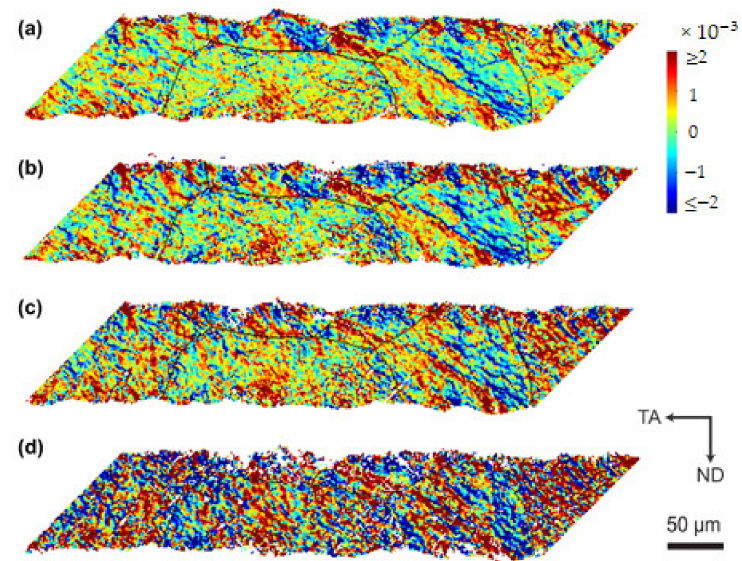
Figure 4. Maps of the deviatoric strain along the tensile axis ε (cid:48) TA for the six Al grains at different tensile strains. ( a ) 0.23%; ( b ) 0.45%; ( c ) 0.83%; ( d ) 1.66%.